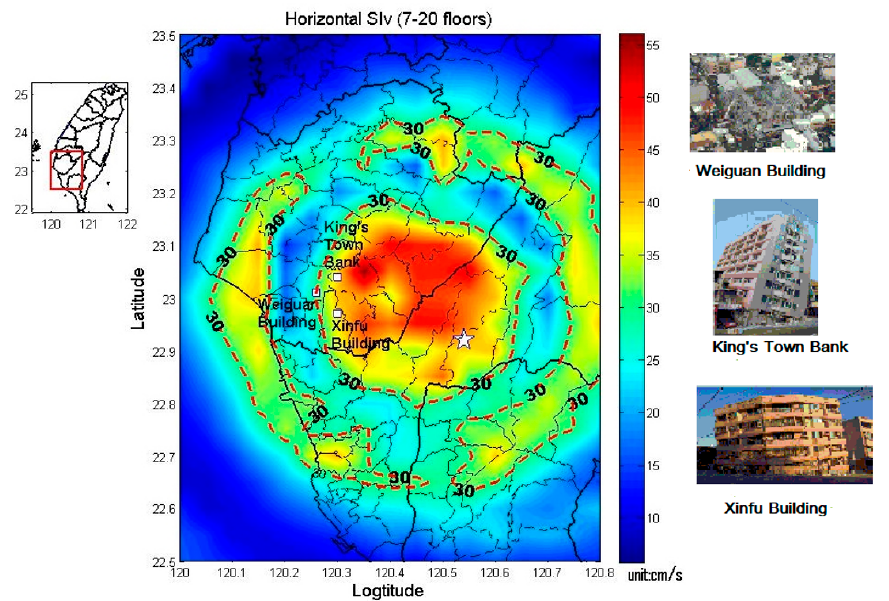
Figure 9. SIv distribution calculated using the inverted source model. The dashed line indicates areas with an SIv value of 30 cm/s; damaged buildings taller than 7 floors were located within the contour line.